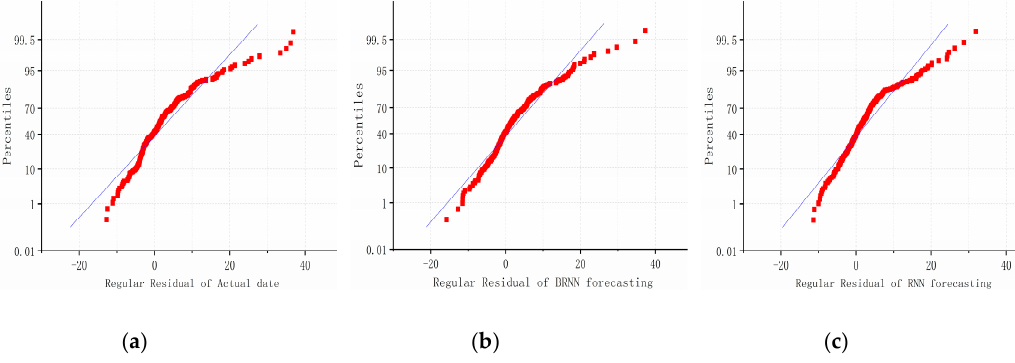
Figure 13. The graph designated ( a ) is the regular residual of actual data under the percentiles form, ( b ) is the regular residual of BRNN forecasting under the percentiles form, and ( c ) is the regular residual of RNN forecasting under the percentiles form.